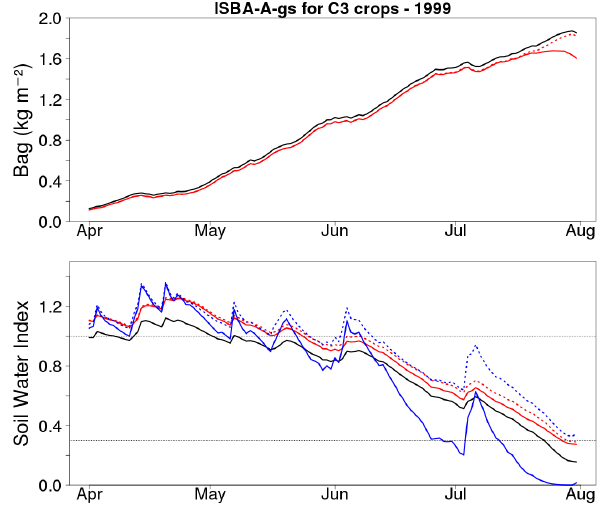
Figure 12. Simulations in 1999 for C3 crops ( g m = 1.75mms − 1 , MaxAWC = 225mm, d R = 1.76m) in the 61-Orne department of (top panel) above-ground biomass, and (bottom panel) SWI TOP (d R ) for FR-2L (black line), DIF1 (red solid line), and DIF1-Uniform (red dotted line), and SWI TOP (0.46m) for DIF1 (blue solid line) and DIF1-Uniform (blue dotted